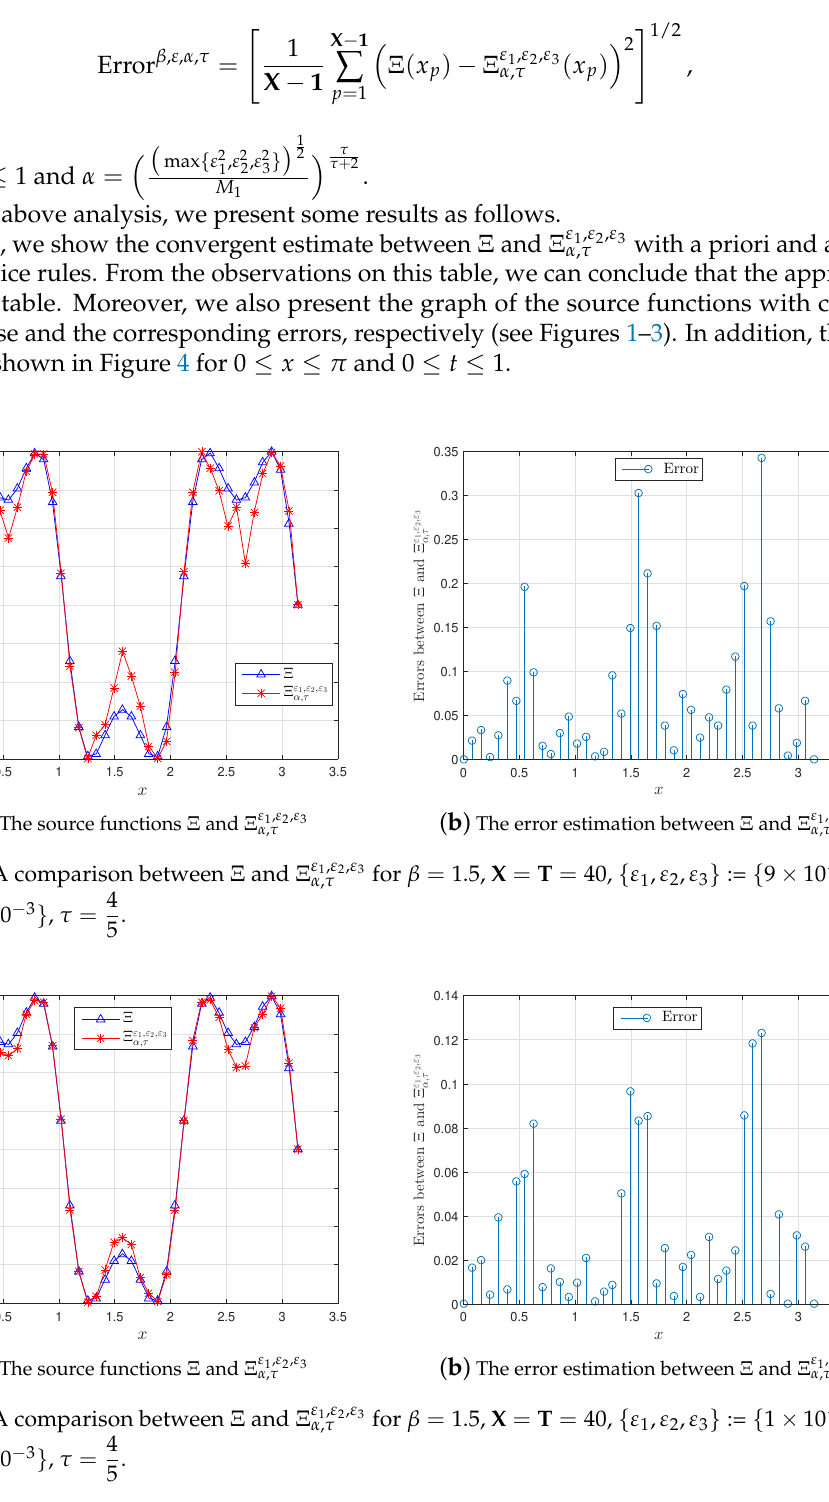
Figure 2. A comparison between Ξ and Ξ ε 1 , ε 2 , ε 3 α , τ for β = 1.5, X = T = 40, { ε 1 , ε 2 , ε 3 } := { 1 × 10 − 3 ,2 × 4 10 − 3 ,3 × 10 − 3 } , τ =